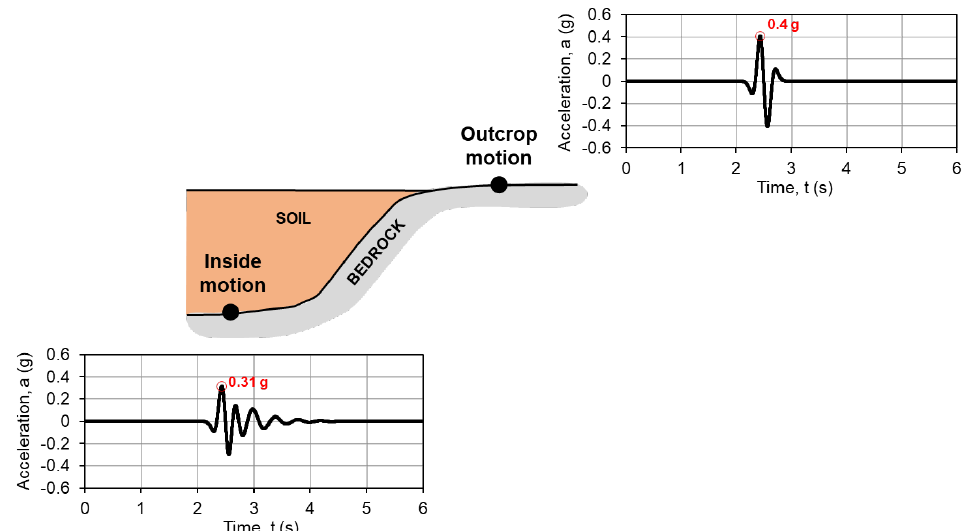
Figure 4. Reference sketch for the definition of the input seismic motion: ‘outcrop motion’ of the outcropping rock and ‘inside motion’ at the interface between the rock bedrock and the deformable soil deposit. The time histories of acceleration show the outcrop and inside motions of the consid- ered ideal case (PGA highlighted with a symbol), both available in the Supplementary material S1.